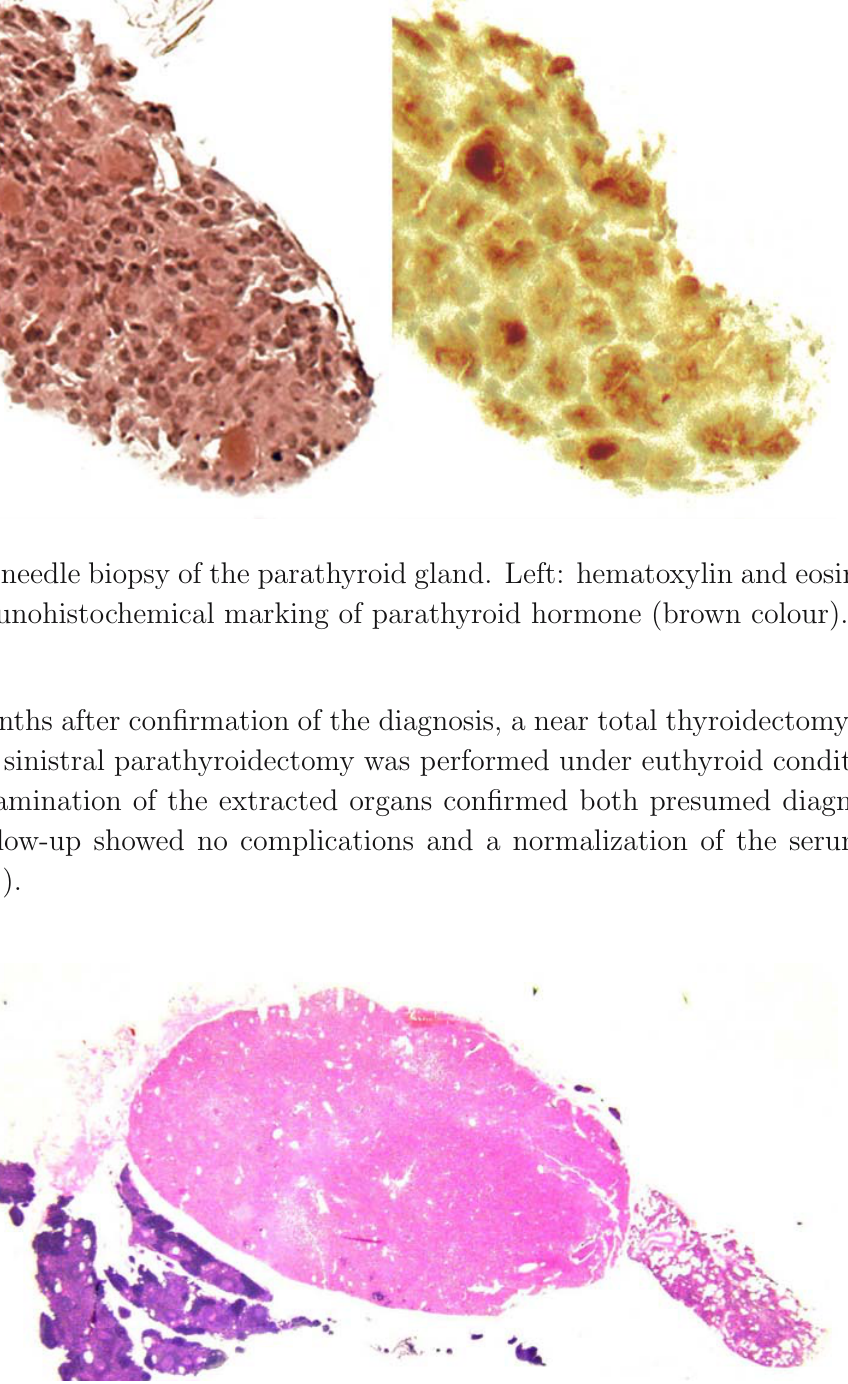
Fig. 3 Parathyroid adenoma (hematoxylin and eosin staining). The right side shows regressive transformation of the residual parathyroid gland. The sections of thymus tissue are shown in the left lower